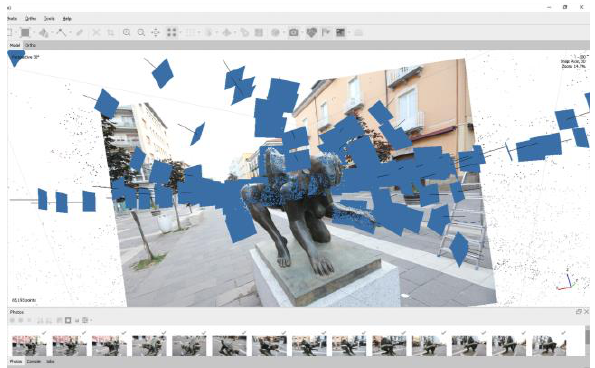
Figure 7 . Photomodeling on Agisoft Metashape platform of the same case